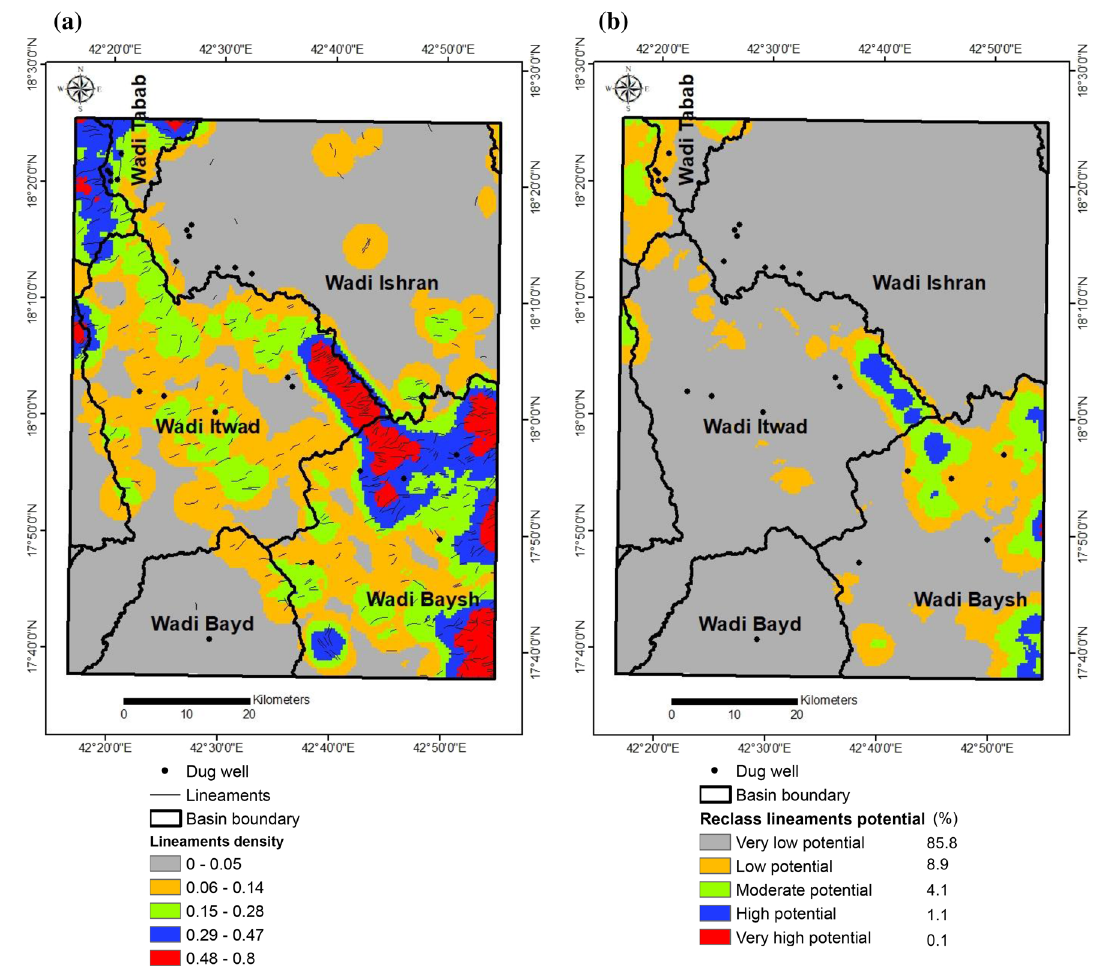
Fig. 9 a Lineaments density and b Reclassified lineament density of the study